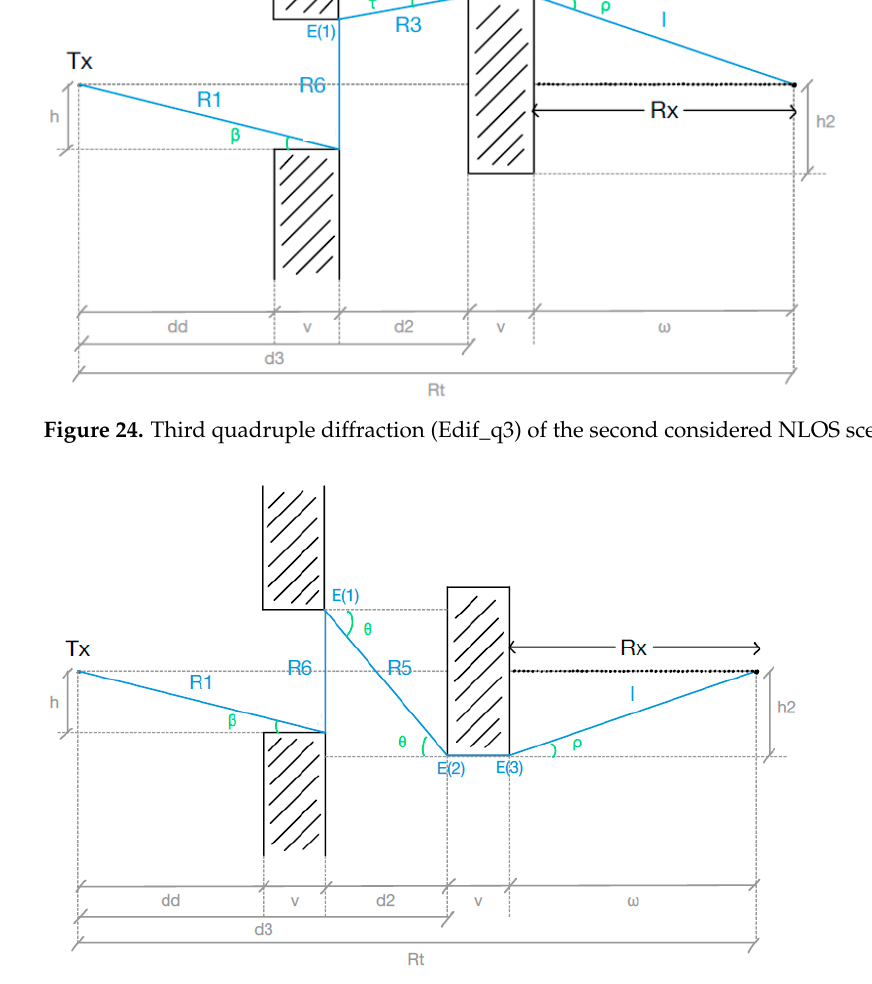
Figure 25. Fourth quadruple diffraction (Edif_q4) of the second considered NLOS scenario.